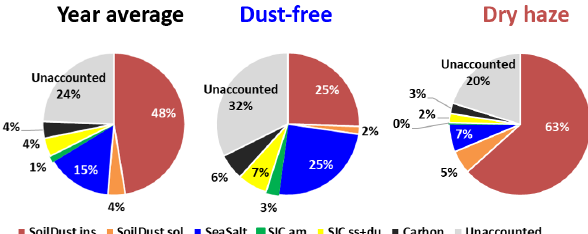
Figure 3. Contribution of different components to the PM 10 mea- sured total mass, estimated by IMB, for the whole sampling cam- paign and for the dust-free and dry-haze